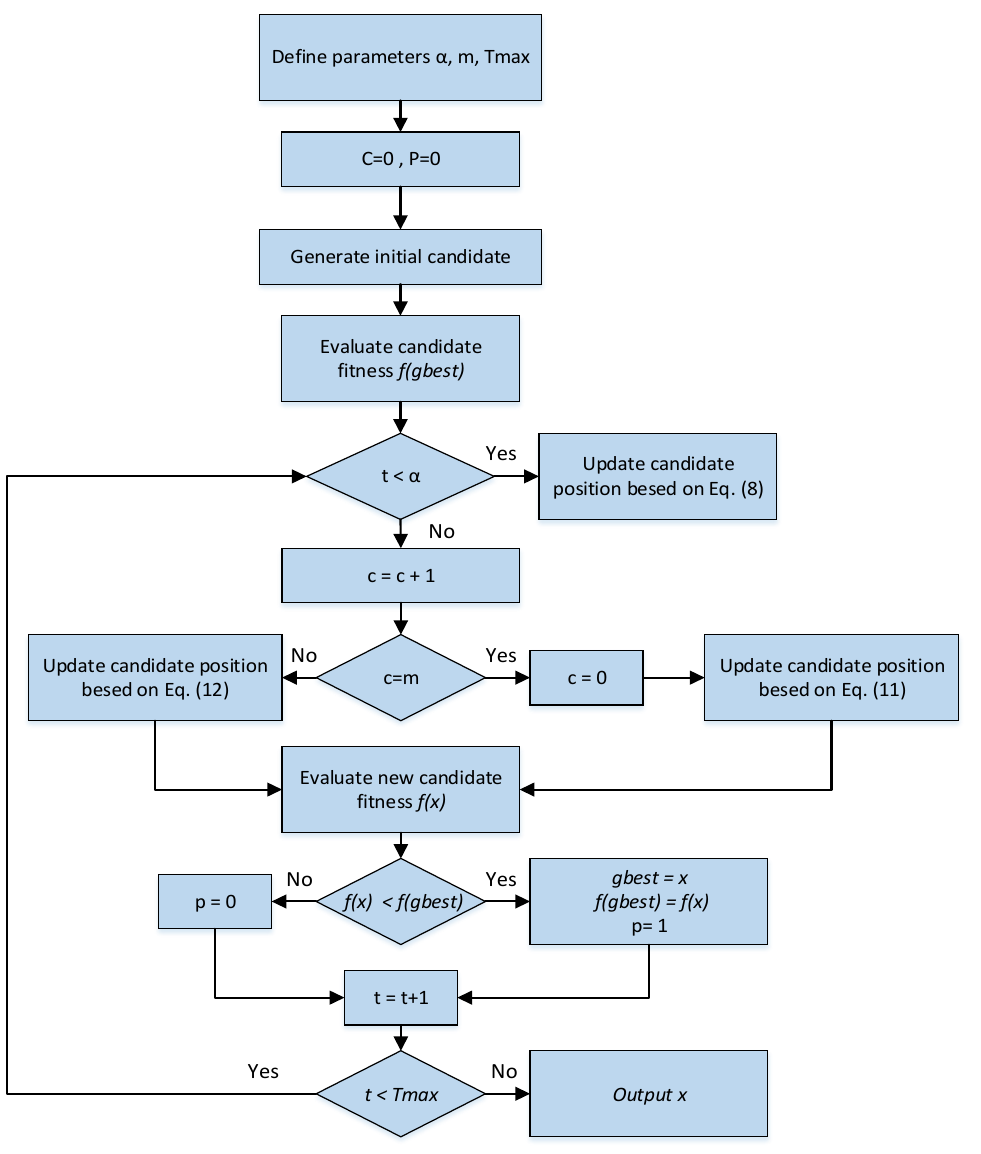
Figure 2. Flowchart of SCO